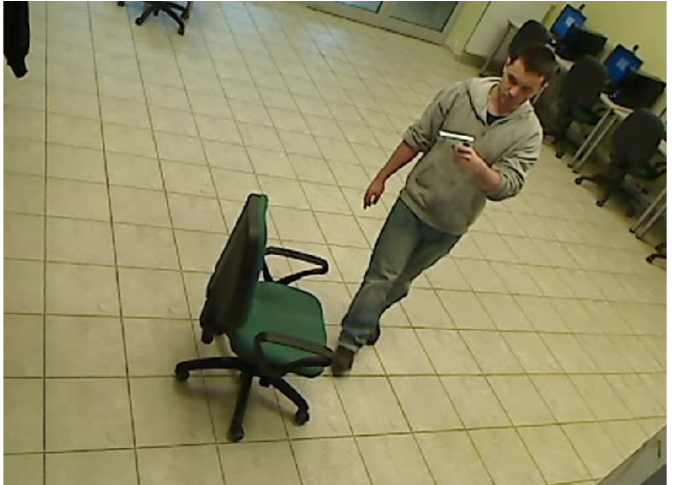
Figure 7. A frame from a dataset movie. Note the poor quality, small size and low contrast of the firearm against the